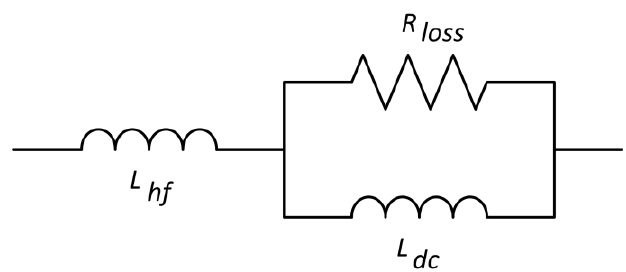
Figure 12: Proposed Leakage Inductance Model in the electrical domain